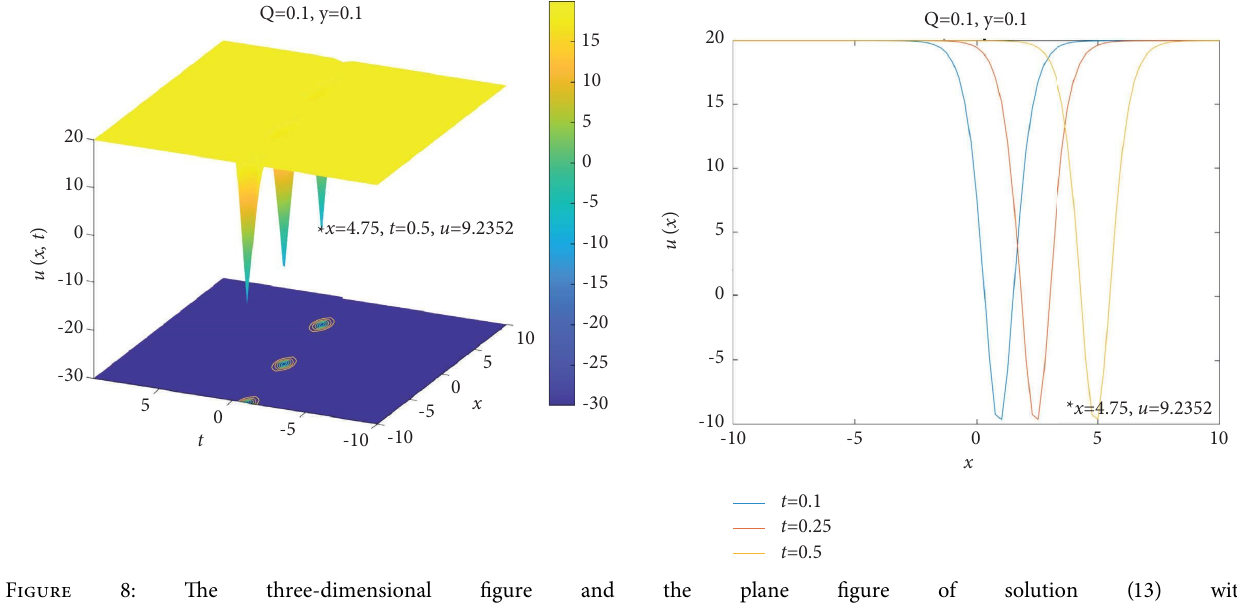
Te three-dimensional fgure and